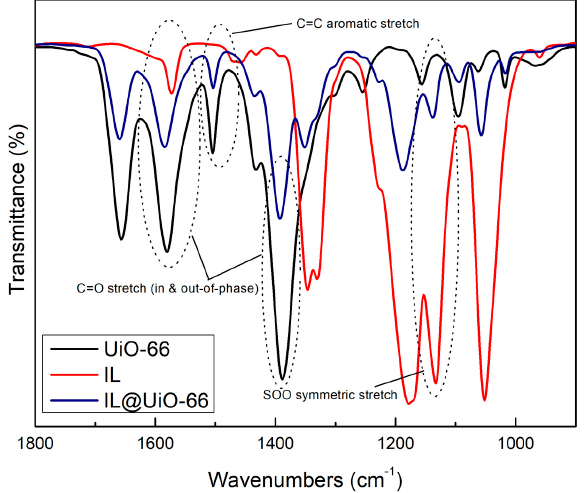
Molecules 2023 , 28 , x FOR PEER REVIEW Figure 11. FTIR spectrum of UiO − 66, IL and IL@UiO − 66 from 1800 to 900 cm − 1 . Figure 11. FTIR spectrum of UiO-66, IL and IL@UiO-66 from 1800 to 900 cm − 1 . Figure 11. FTIR spectrum of UiO − 66, IL and IL@UiO − 66 from 1800 to 900 cm − 1 .